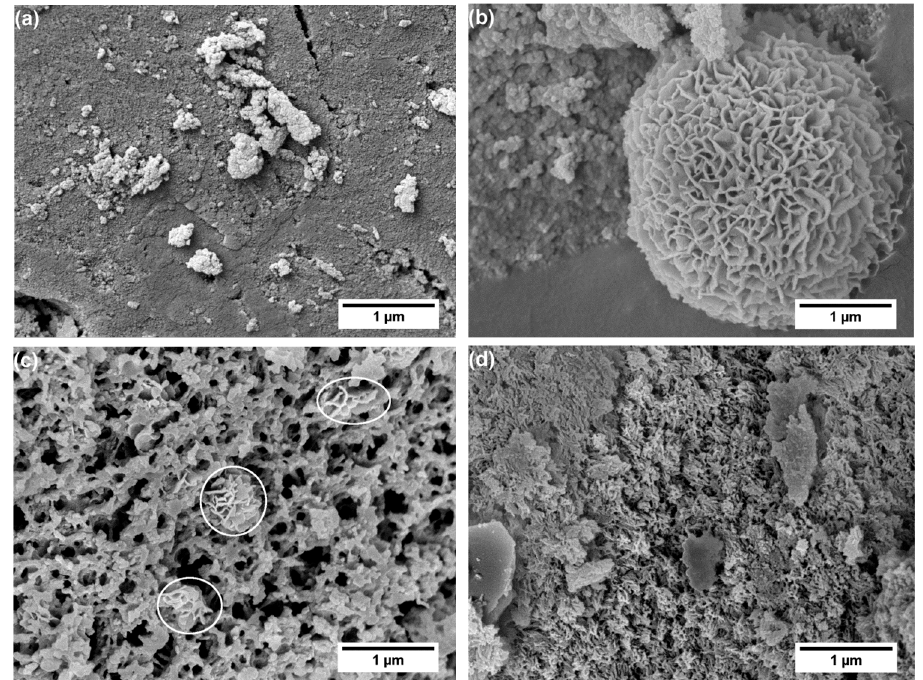
Figure 9. SEM surface morphology analysis of silicon oxycarbide samples after seven days SBF test: ( a ) SiCa0-T, ( b ) SiCa5-T, ( c ) SiCa12-T, and ( d ) SiCa50-T. The hydroxyapatite precipitation is marked in white circles for SiCa12-T.